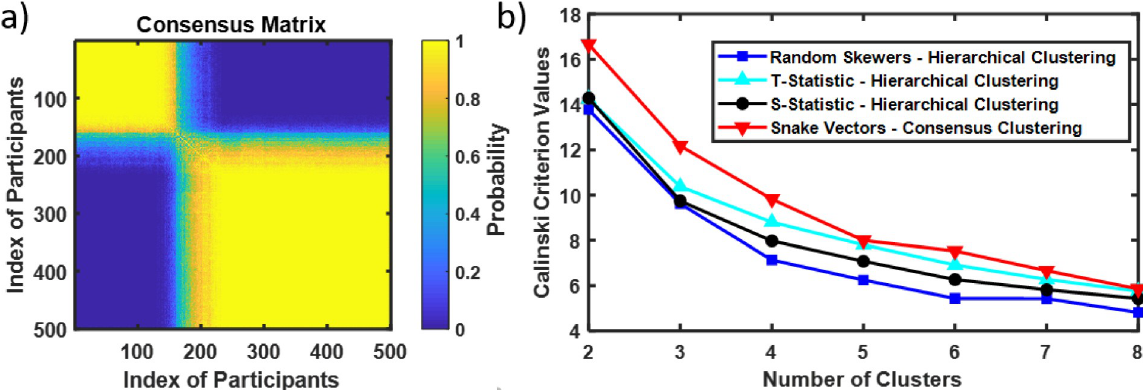
Fig 8. Resampling-based consensus clustering of 500 brain connectivity matrices from GSP project. A- Consensus matrix. Two identified clusters are presented as yellow squares (yellow color indicating the high probability of a pair of brains belonging to the same cluster). High contrast in the on-diagonal and off-diagonal values of probability indicate two clusters. B- Checking the number of clusters with Calinski criterion. Calinski criterion have a maximum at k = 2 indicating two clusters as well (both with snakes-&-dragons approach and with RS, T- and